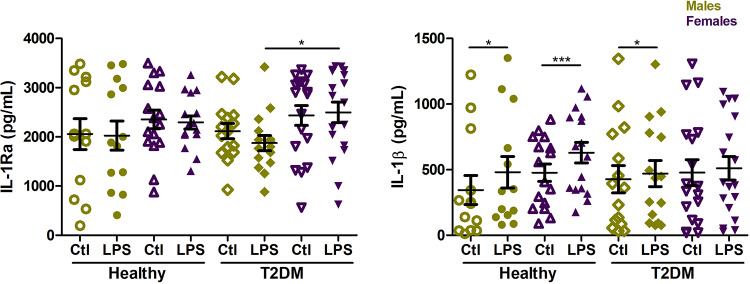
LPS-stimulated production of IL-1Ra and IL-1β by PBMCs from type 2 diabetes mellitus patients (T2DM, n = 32) and healthy controls (Healthy, n = 27).PBMCs isolated from males (green) and females (violet) were treated with LPS (100ng/ml) and left unstimulated as a control (Ctl) for 24h. Data are presented as mean ± SEM. *P< 0.05, ***P< 0.001.